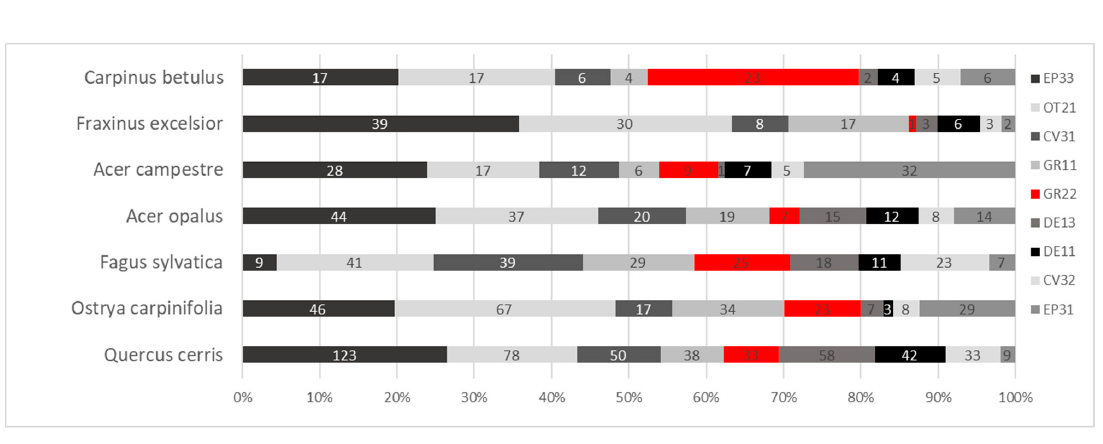
Figure A2. TreMs frequency per species.